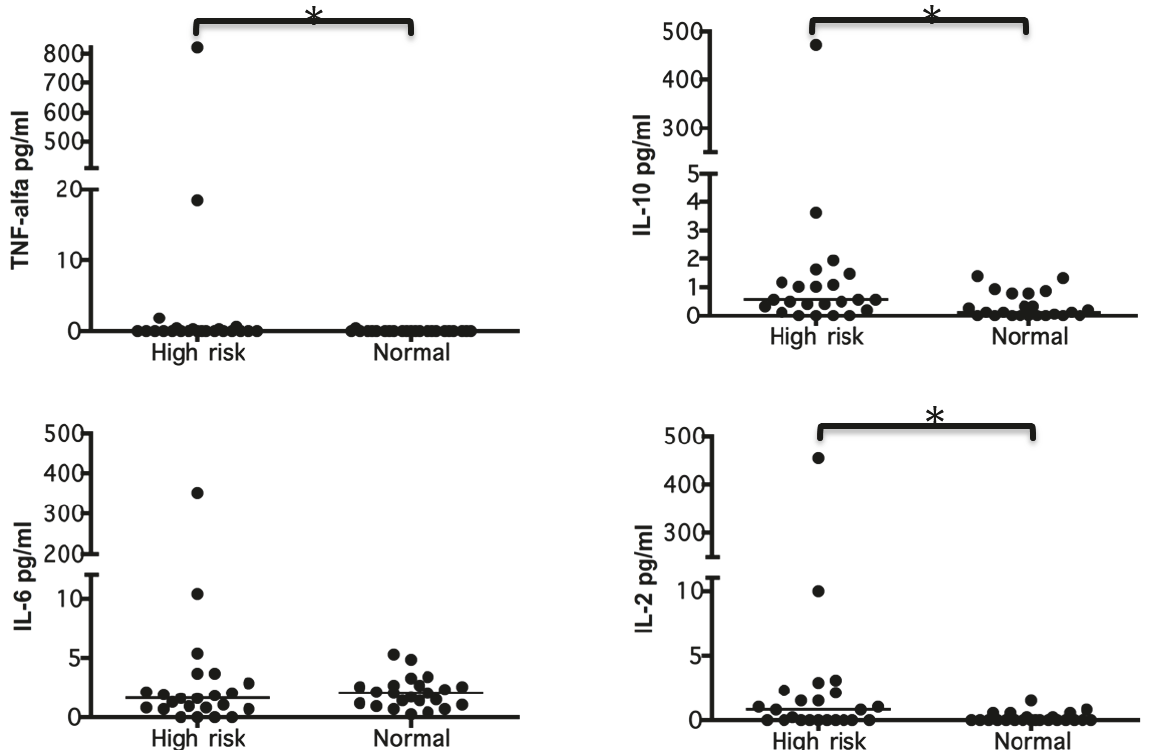
Figure 3: Thequantification of systemiccytokinesin pregnant patientswith (High Risk) andwithout the risk (Normal) of preterm birth. TNF- 𝛼 , IL-10, IL-6, and IL-2 were quantified using the CBA and by Flow Cytometer 50,000 events were acquired and analyzed using FCAP Array software. The concentrations obtained were expressed in pg/ml and compared between groups by a bivariate analysis. The data are represented by the median for each group (n=23 per